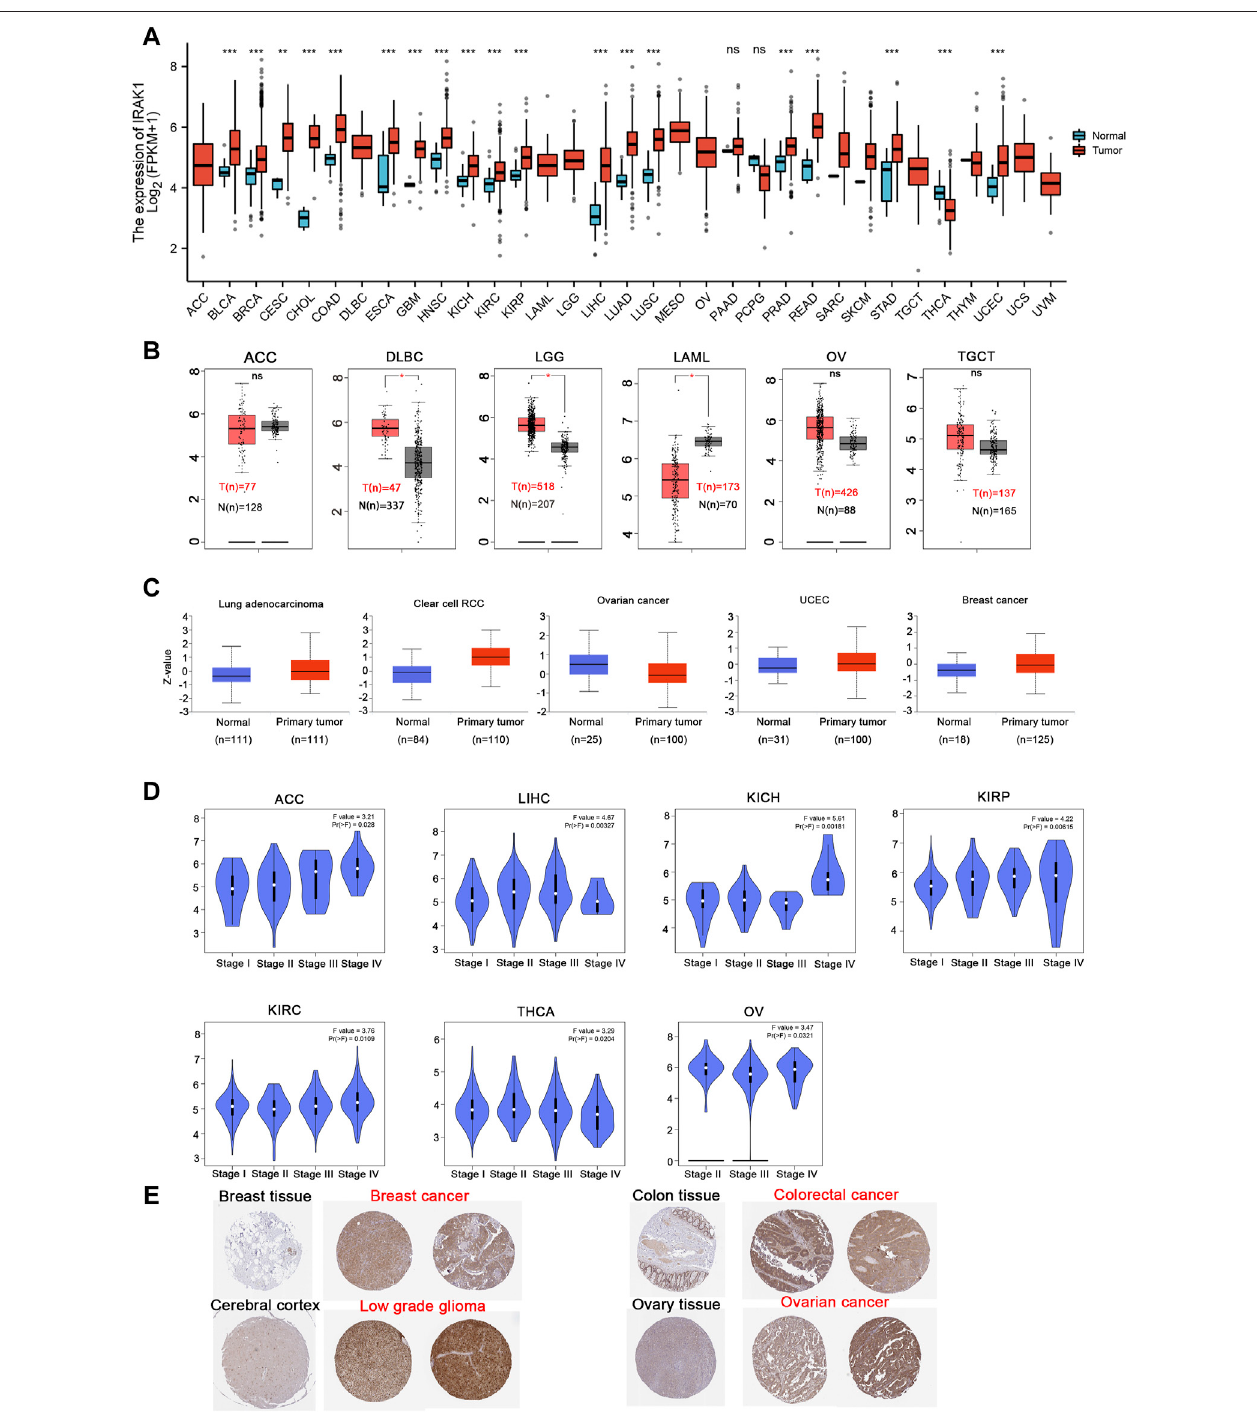
FIGURE1| ExpressionlevelofIRAK1indifferentcancerandpathologicalstages. (A) IRAK1expressionindifferentcancertypesfromtheTCGAdatabaseanalyzed by the TIMER database. * p < 0.05; ** p < 0.01; *** p < 0.001. (B) IRAK1 expression in the cancer type of ACC, DLBC, LGG, LAML, OV, TGCT from TCGA database analyzed by GEPIA database, and the normal tissues were included as controls. ** p < 0.01. (C) The expression level of IRAK1 total protein between normal tissue and primary tissue of lung adenocarcinoma, clear cell RCC, ovarian cancer, UCEC and breast cancer were analyzed from the CPTAC dataset. *** p < 0.001. (D) The expression of IRAK1 based on the different pathological stages were analyzed in ACC, LIHC, KICH, KIRP, KIRC, THCA, OV in the TCGA database. (E) Representative immunohistochemical staining of IRAK1 in breast cancer, colorectal cancer, low grade glioma and ovarian cancer from the HPA (http://www.proteinatlas.org/).